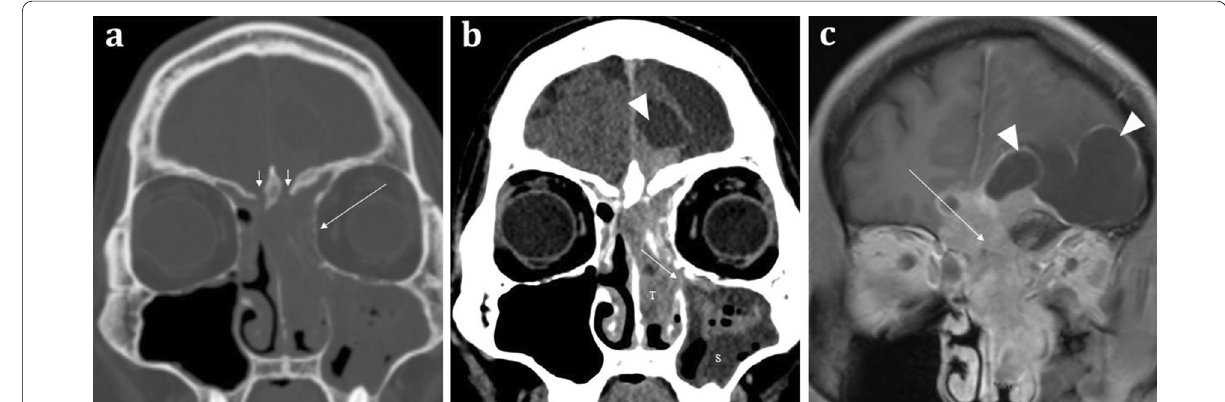
Fig. 12 Olfactory neuroblastoma (Esthesioneuroblastoma) in a 41-year-old male presenting with a 2-month history of change in behaviour and anosmia. Coronal bone ( a ) and soft tissue window ( b ) CT images demonstrate a large anterior skull base mass centred upon the olfactory neuroepithelium. There is extensive bone destruction of the left and right cribriform plates and turbinates (short arrows, a ), and thinning of the medial wall of the left orbit (long arrow, a ). There is also inferior extension of the tumour (T) through the ethmoid air cells into the nasal cavity and extending through the left middle meatus into the maxillary sinus (arrowed, b ). The soft tissue density of the tumour (T) is distinct from the left maxillary sinus fluid contents (S). Note the fluid density intracranial “capping cysts” at the left frontal lobe (arrowhead, b ). Coronal T1WI with contrast ( c ) depicts a tumour with moderately intense contrast uptake, conforming to a “dumbbell-shape” with a “waist” at the cribriform plate (arrowed, c ). Again, note the presence of T1 hypointense “capping cysts” at the intracranial margin, which are a distinguishing feature of these tumours (arrowheads, c